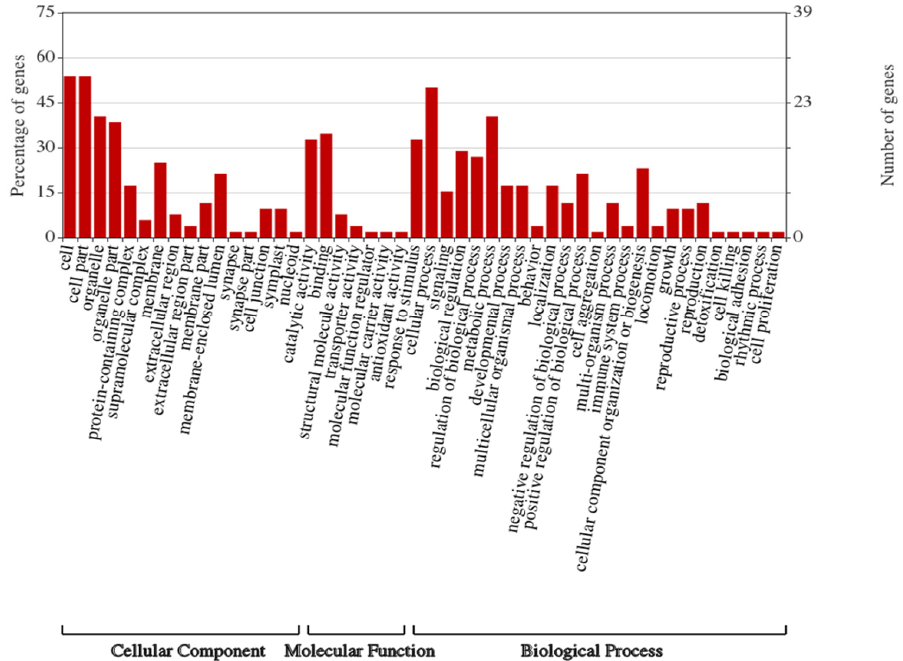
Figure 3. Gene Ontology (GO) distribution plotted by WEGO. The proteins were assigned to three main categories: biological process, molecular function and cellular component. The right-hand y-axis indicates the number of annotated proteins. The left-hand y -axis indicates the percentage of annotated proteins.